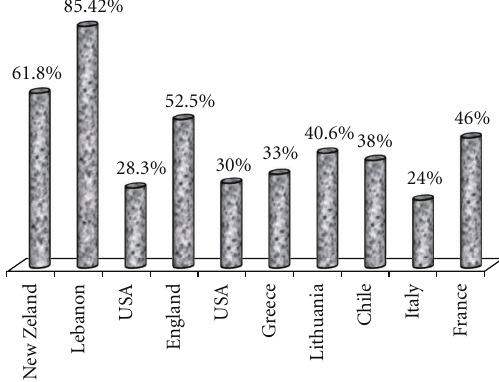
Figure 3: Sunburn incidence according to